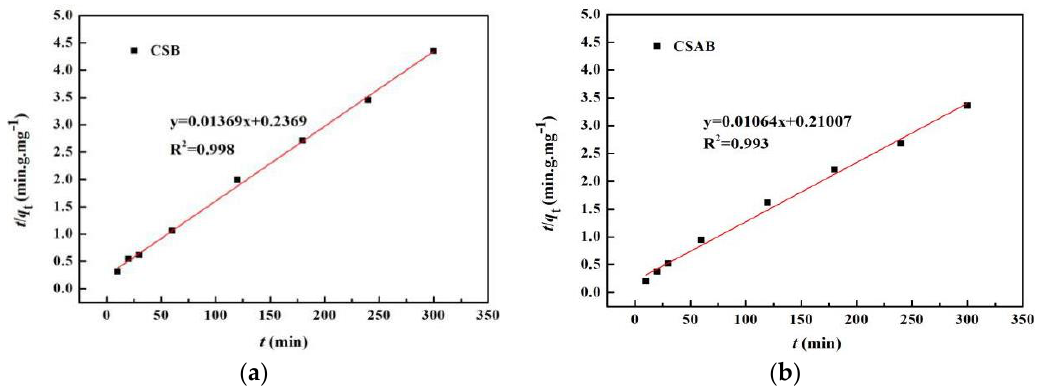
Figure 9. Pseudo first-order model for adsorption of diesel oil onto: ( a ) CSB; ( b ) CSAB.